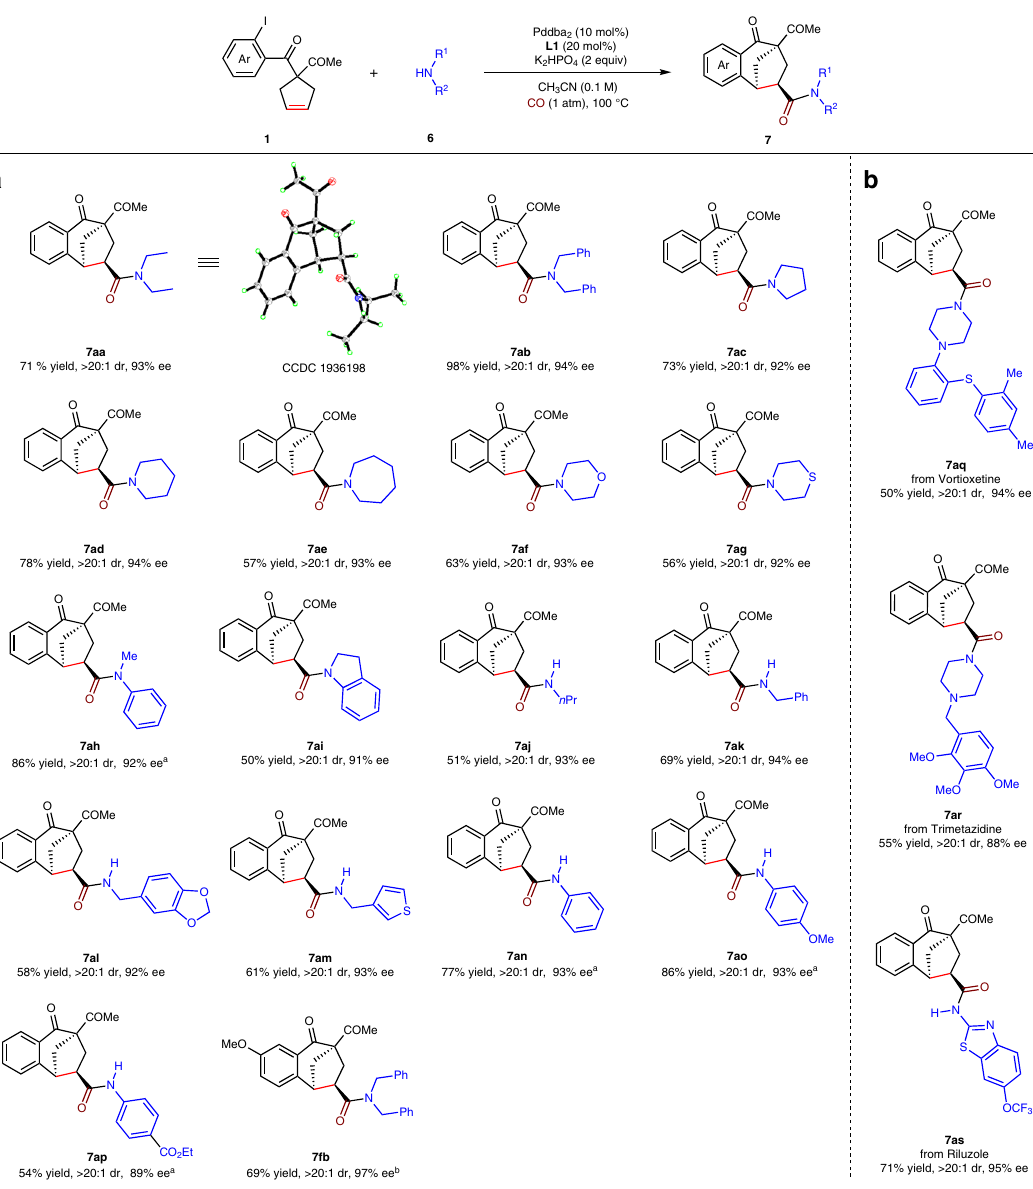
Fig. 4 Substrate scope. a Substrate scope of amines. b Application to asymmetric late-stage functionalization of pharmaceuticals. Reaction conditions: 1a (0.1 mmol), 6 (0.2 mmol), Pddba 2 (10 mol%), L1 (20 mol%), K 2 HPO 4 (0.2 mmol) in CH 3 CN (1 mL), 100 °C, 36 h, under CO (1 atm). Yields of isolated products are given. The dr values were determined by 1 H NMR analysis. The ee values were determined by HPLC analysis on a chiral stationary phase. a K b 48 2 HPO 4 was replaced by KHCO 3 , 48 h.